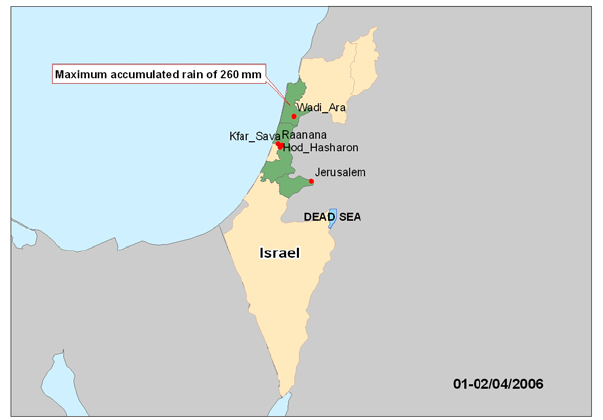
Fig. 6. Map of Israel with the affected areas in the event of 1– 2 April 2006. Fig. 6 . Map of Israel with the affected areas in the event of 1-2 April 2006.